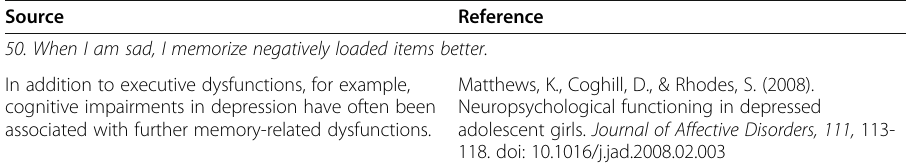
Table 6 Memory-related affect; exemplar item with the source and reference Source Reference 50. When I am sad, I memorize negatively loaded items